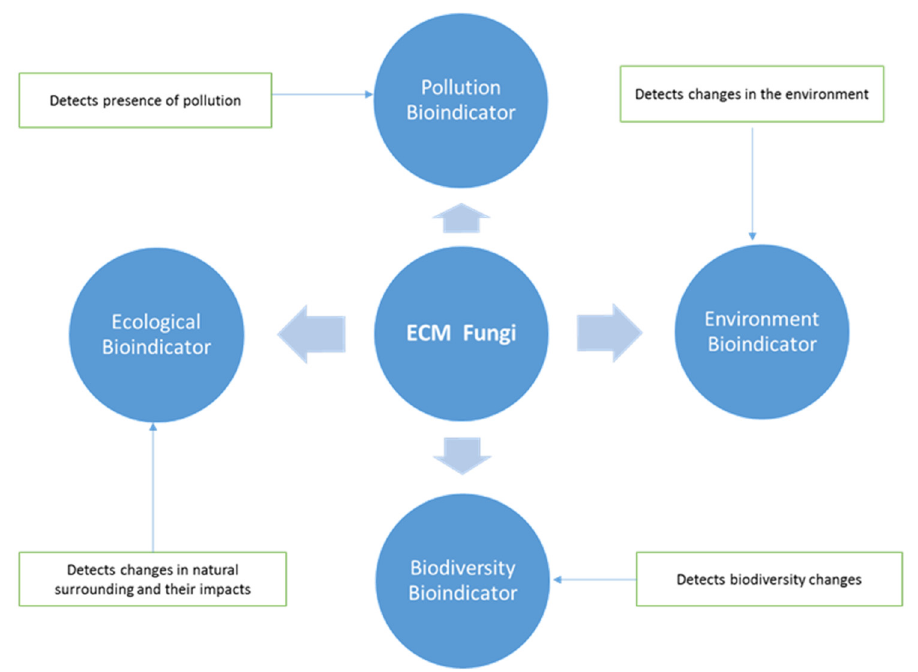
Figure 2. Different bio-indicator functions, which are performed by EM mushrooms.